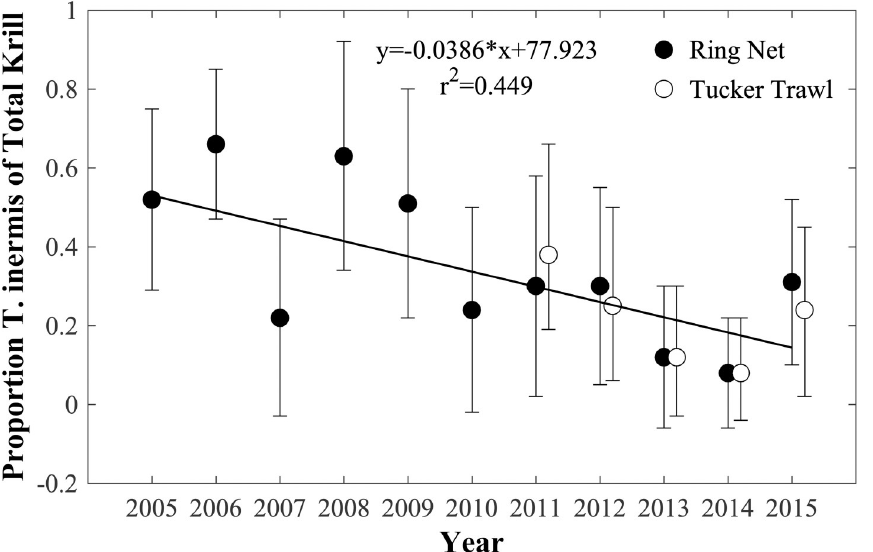
Fig 3. Annual mean proportion of T . inermis of the total krill abundance. Mean proportions for samples from both the ring net and Tucker trawl are shown. Regression conducted using only data from ring net. Error bars show standard deviations.